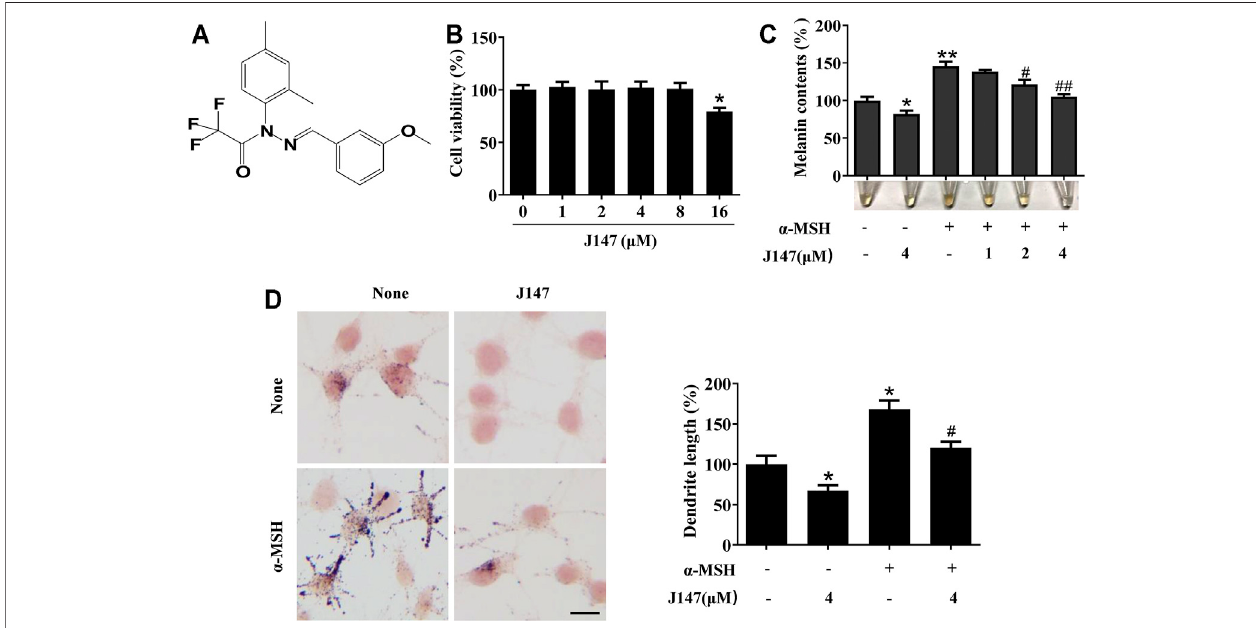
FIGURE 1 | Effect of J147 on melanogenesis in B16F10 cells. (A) The chemical structure of J147. (B) After incubation of with various concentrations (1 – 16 μ M) of J147 for 48 h, cell viability was determined using MTT assay. (C) B16F10 cells were treated with J147 in the presence or absence of α -MSH (60 nM) for 48 h. Melanin contents were measured as described in methods. (D) B16F10 cells were treated with J147 for 48 h and were stained with Masson – Fontana ammoniacal silver stain. Bar (cid:2) 20 μ m.Totallengthofdendritespercellwasmeasuredonthepicturesusingruler.Dataareexpressedasthemean ± SD( n (cid:2) 3).* p < 0.05,** p < 0.01vs.non- treated cells. # p < 0.05, ## p < 0.01 vs. α -MSH-treated